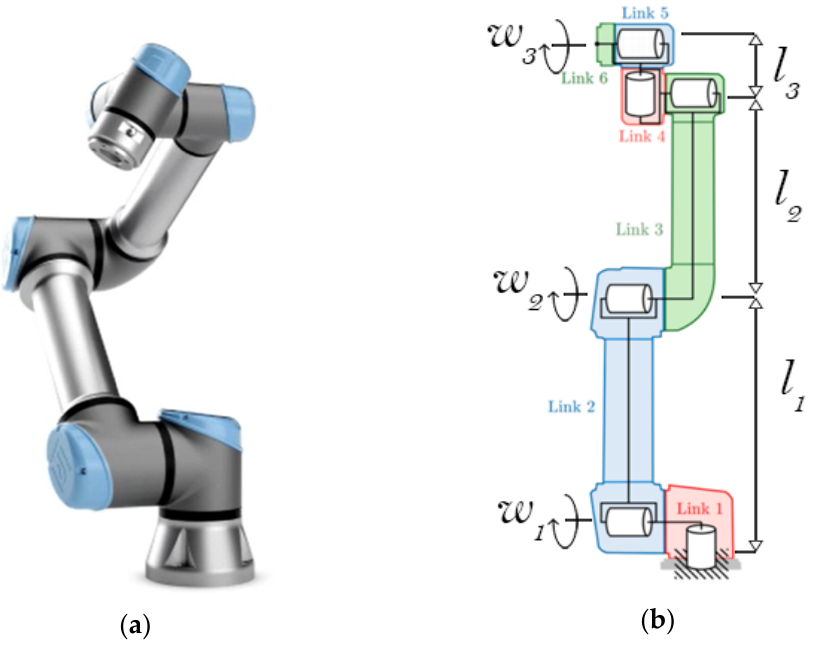
Figure 2. ( a ) Commercial collaborative robot for accident scenarios [36]. ( b ) Robot Configuration for calculation of equivalent mass.